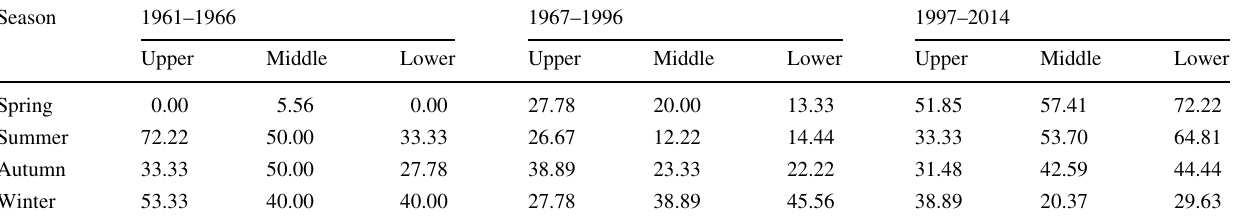
Table 4 Seasonal drought frequency (%) in the upper, middle, and lower reaches of the Heihe River Basin in the three time periods during